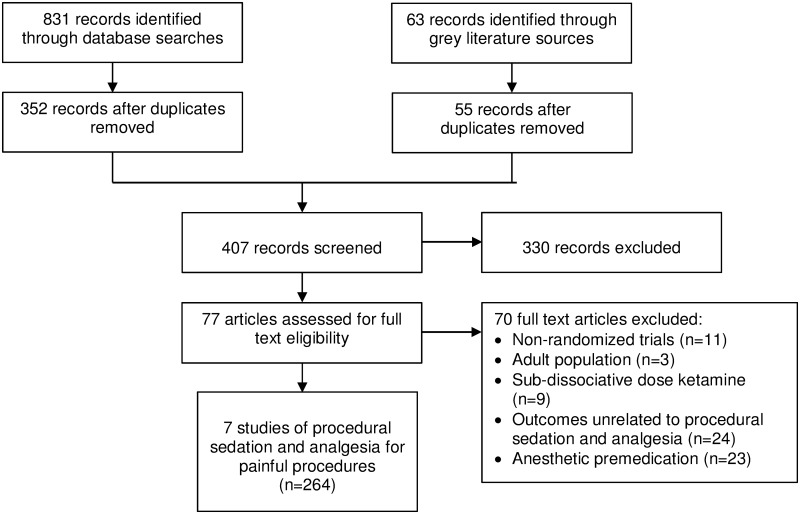
Study flow diagram.